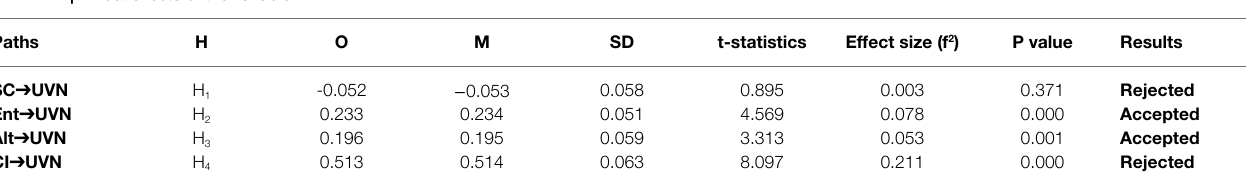
TABLE 4 | Direct effects of the variable.